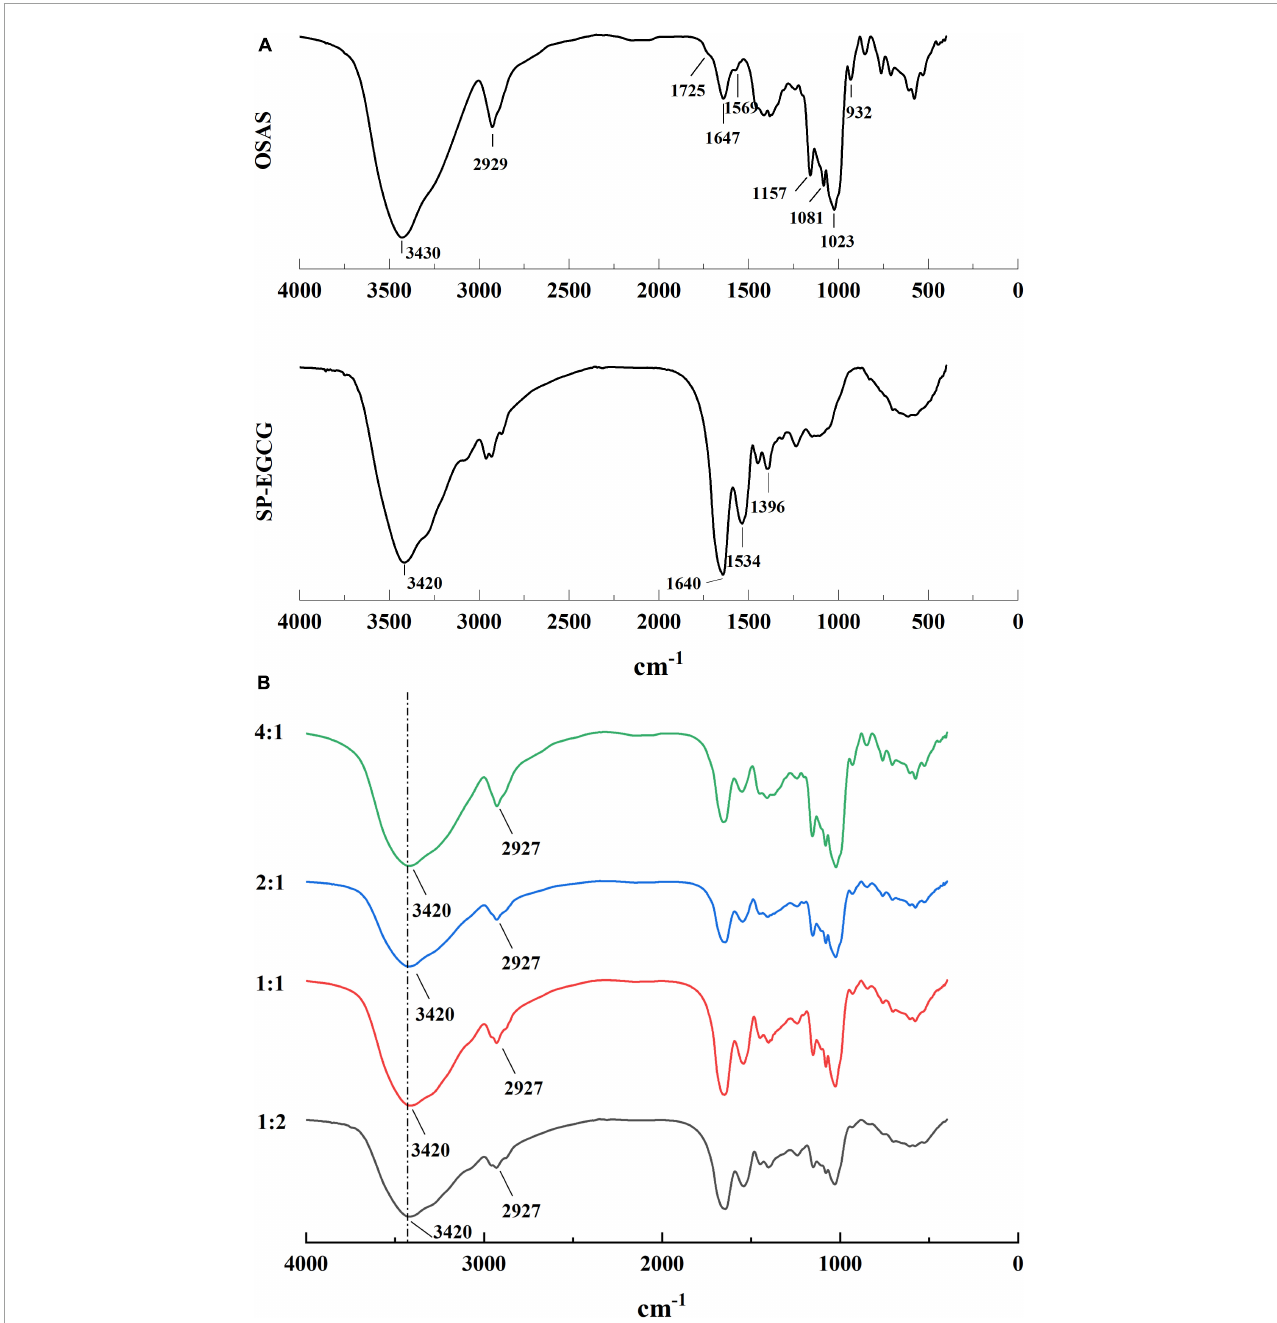
FIGURE3 FTIR spectrum for OSAS, SP-EGCG complexes (A) and OSAS-SP-EGCG complexes (B)